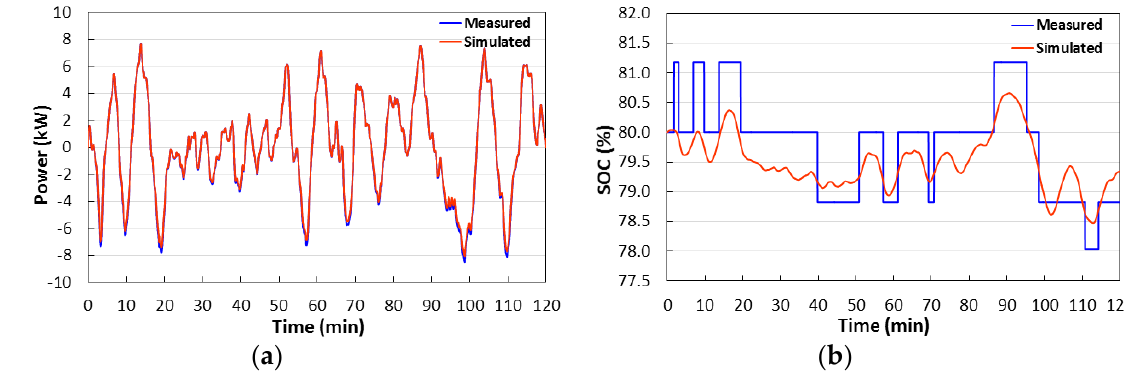
Figure 14. Simulink-based Simulation of ( a ) AC output from DC fast charger (DCFC)/EV (positive: charging, negative: discharging) and ( b ) SOC variation obtained from empirical testing and simulation using a normalized 2 h average standard deviation signal on single-vehicle-based SFC operation for 2 h (starting SOC: 80.0%).